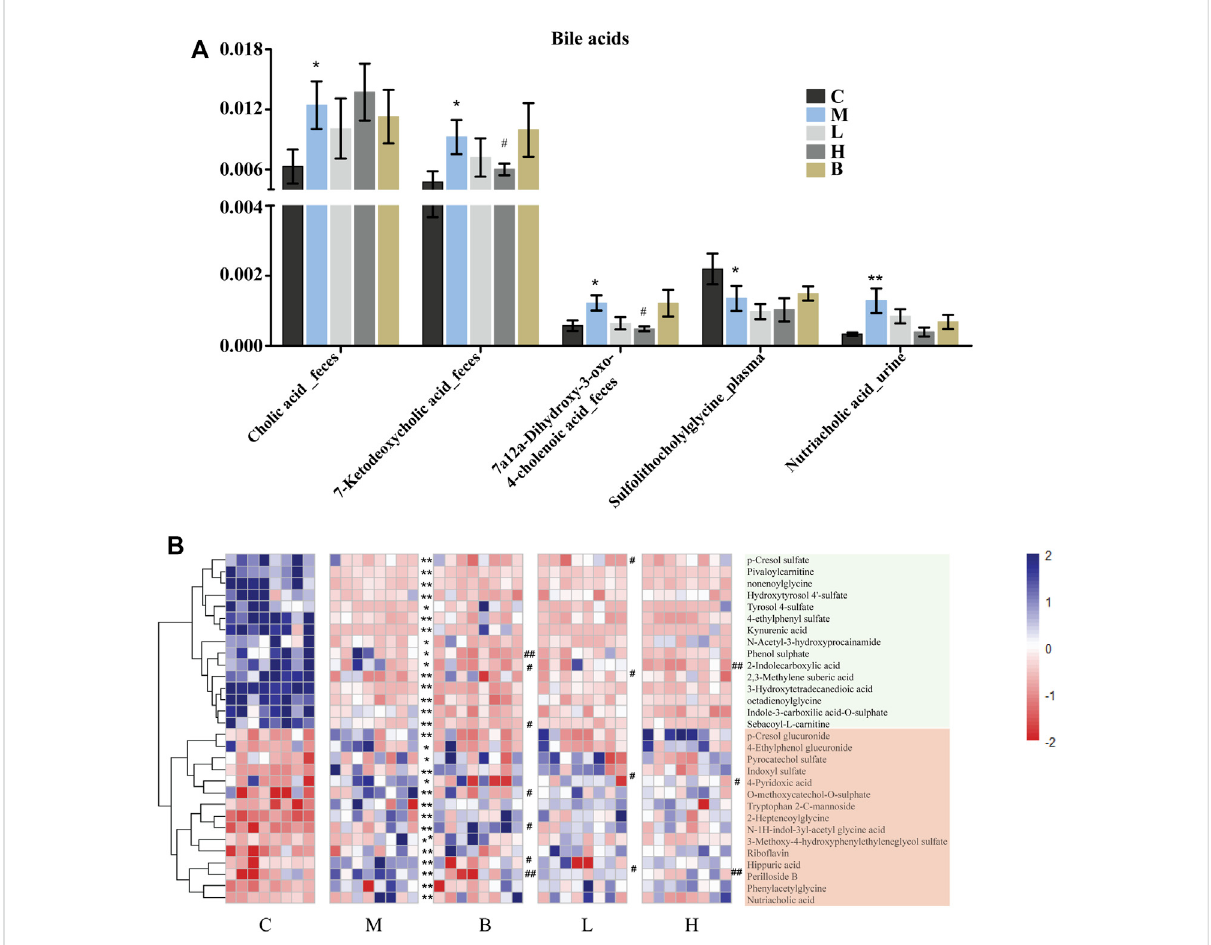
FIGURE 3 Signi fi cantly differentially abundant bile acid metabolites in HUA rats and the differentially abundant metabolites in the urine of HUA rats. (A) Comparison of signal intensity of signi fi cantly differentially abundant bile acid metabolites in control group (C), HUA model group (M), positive drug (benzbromarone)group(B),low-doseAMUPgroup(L),andhigh-doseAMUPgroup(H). (B) Heatmapofthedifferentiallyabundantmetabolitesinthe urine of HUA rats. Each cell represents one compound. Deeper blue represents higher levels and deeper red represents lower levels. * p < 0.05 compared with group C; ** p < 0.01 compared with group C; # p < 0.05 compared with group M; ## p < 0.01 compared with group